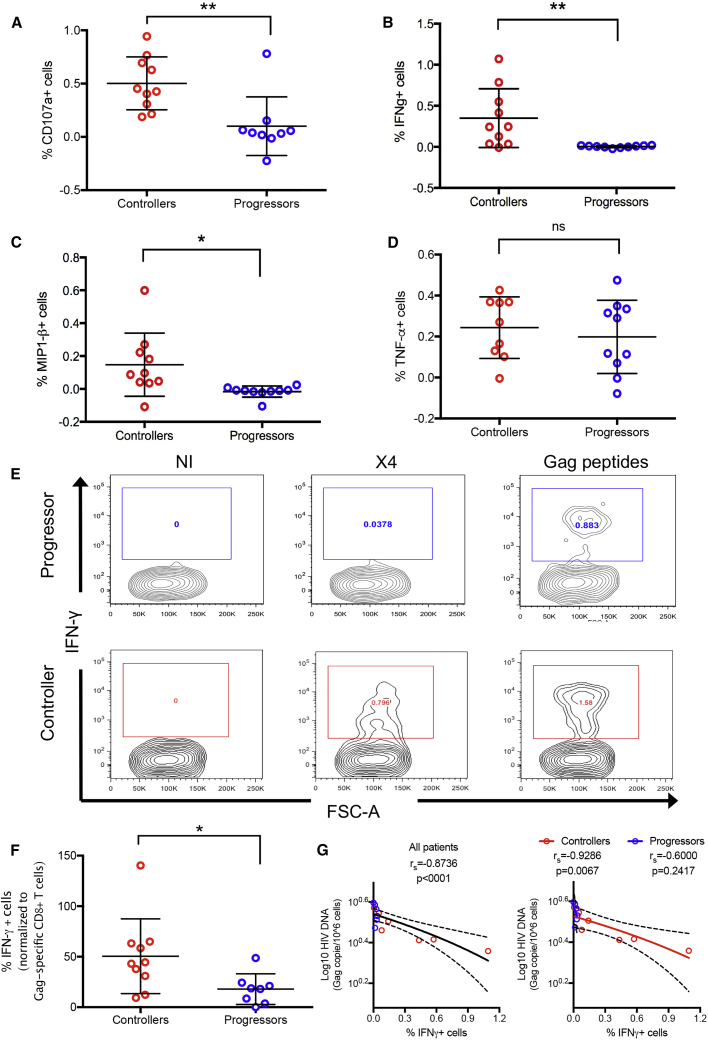
The CD8+ T Cell Response to HIV+ Non-activated CD4+ T Cells Participates in HIV Control(A–D) CD8+ T cell responses from HIV controller (red) or progressor (blue) patients (all HLA-B∗27 or B∗57, and n = 10 patients for both groups) in the context of whole non-activated PBMCs were measured by (A) CD107a expression, (B) intracellular IFN-γ expression, (C) intracellular MIP-1β expression, and (D) intracellular TNF-α expression after 2 h of HIV infection and 5 h of incubation. Results are shown following background subtraction. Statistical differences were assessed using PRISM software and an unpaired t test. ∗p < 0.05, ∗∗p < 0.01, and ns, not statistically significant.(E) CD8+ T cell response to Gag pool peptides (final concentration 1 μg/mL/peptide) was measured for each patient by intracellular IFN-γ staining. A representative experiment is shown for an HIV progressor (top) and for an HIV controller (bottom).(F) The CD8+ T cell response to HIV+ non-activated CD4+ T cells expressed relative to the Gag pool peptide response.(G) The HIV DNA reservoir was measured by droplet PCR, and the Spearman correlation between the log10 of Gag copies/106 non-activated CD4+ T cells and the CD8+ T cell IFN-γ response is shown for all of the patients (left, n = 12 patients) and by sub-groups (right, n = 6 patients for each group).See also Table 1 and Figures S5 and S6.